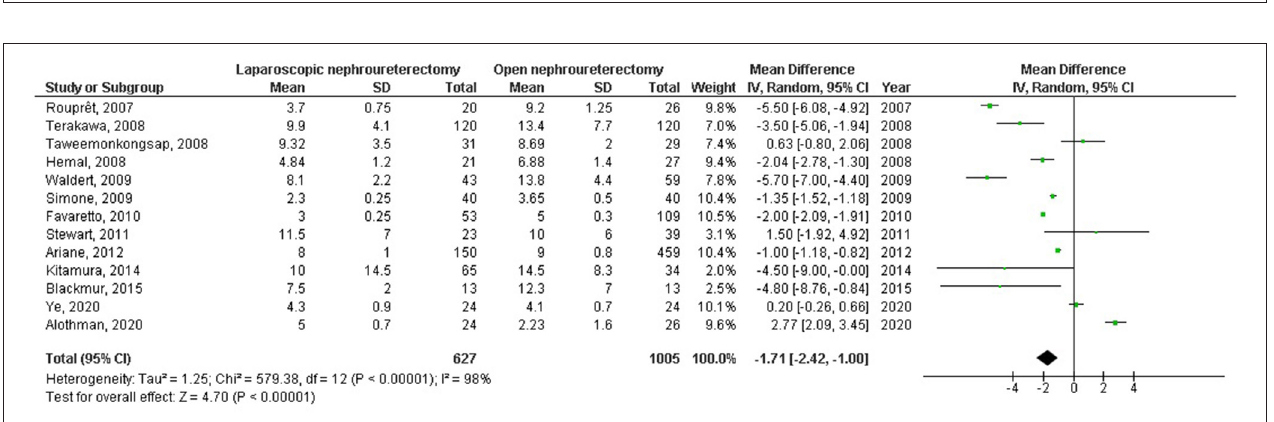
FIGURE 4 | Forest plot of the effect of open nephroureterectomy compared with laparoscopic nephroureterectomy on blood loss in subjects with upper urinary tract urothelial carcinoma.